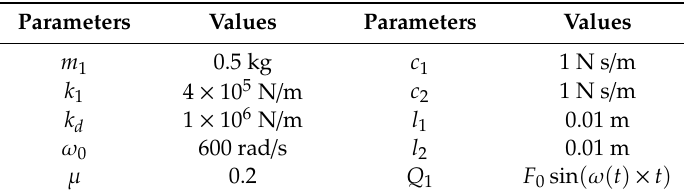
Table 1. The parameters of the system.